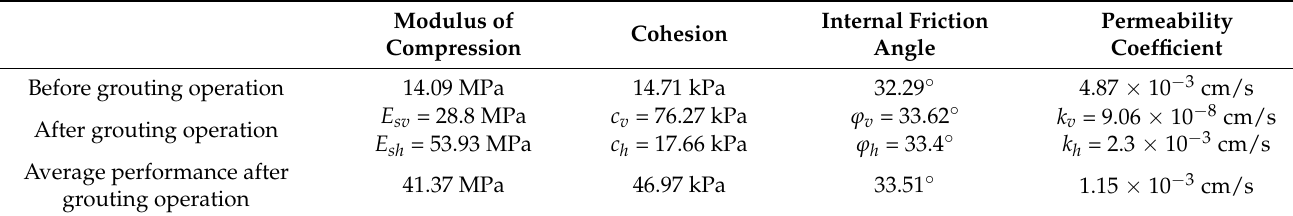
Table 7. Calculation results of macroscopic performance parameters of sand layer.